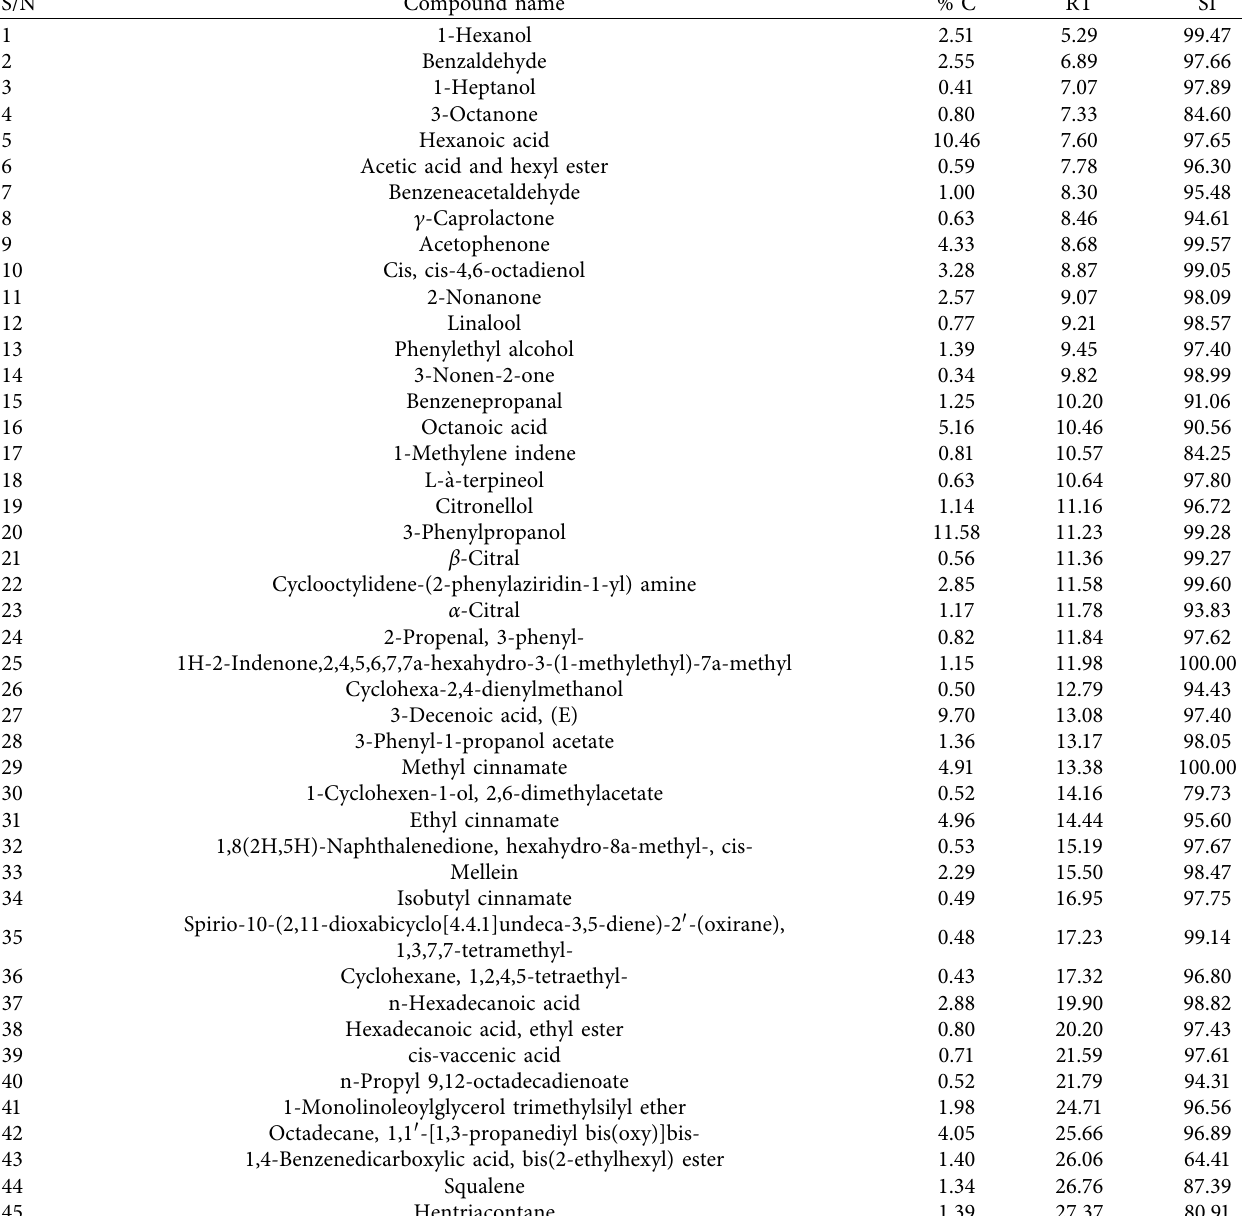
Table 1: Chemical composition of the essential oil obtained from the fruit of Vitex doniana